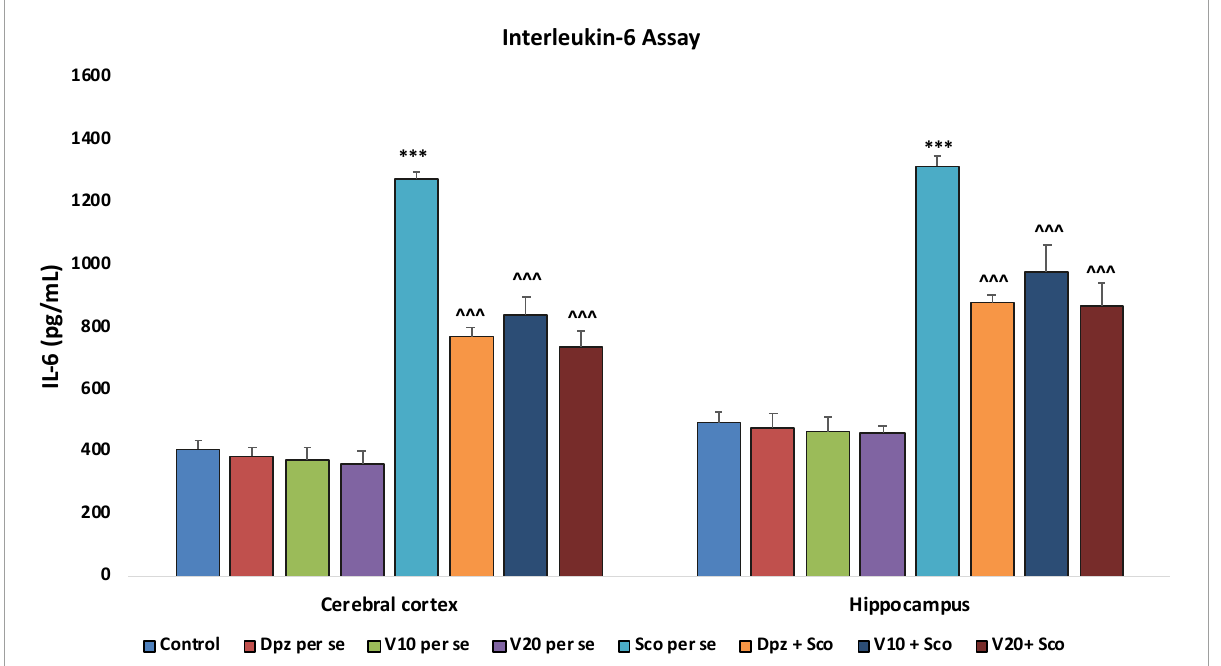
FIGURE22 Effect of vanillin and other treatments on IL-6 concentrations. Data are expressed as mean ± SEM. “***” denotes P < 0.001 with respect to the control group. “ ∧∧∧ ” denotes P < 0.001 with respect to the negative control (Sco pe r se) group.